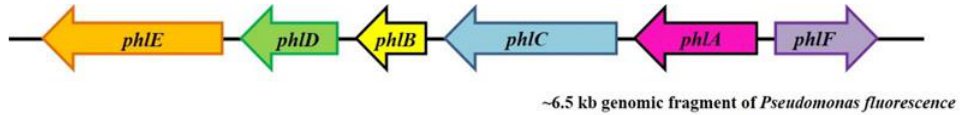
Figure 1. Schematic representation of a ~6.5 kb genomic fragment of Pseudomonas harboring the genes responsible for the biosynthesis of 2,4-DAPG by phl operon. phl operon comprises four genes phl A , phl B , phl C , and phl D . The operon is flanked on either side by phl E and phl F genes that are separately transcribed and coded for the putative efflux and regulatory (repressor) proteins, respectively. They are not required for phloroglucinol production.